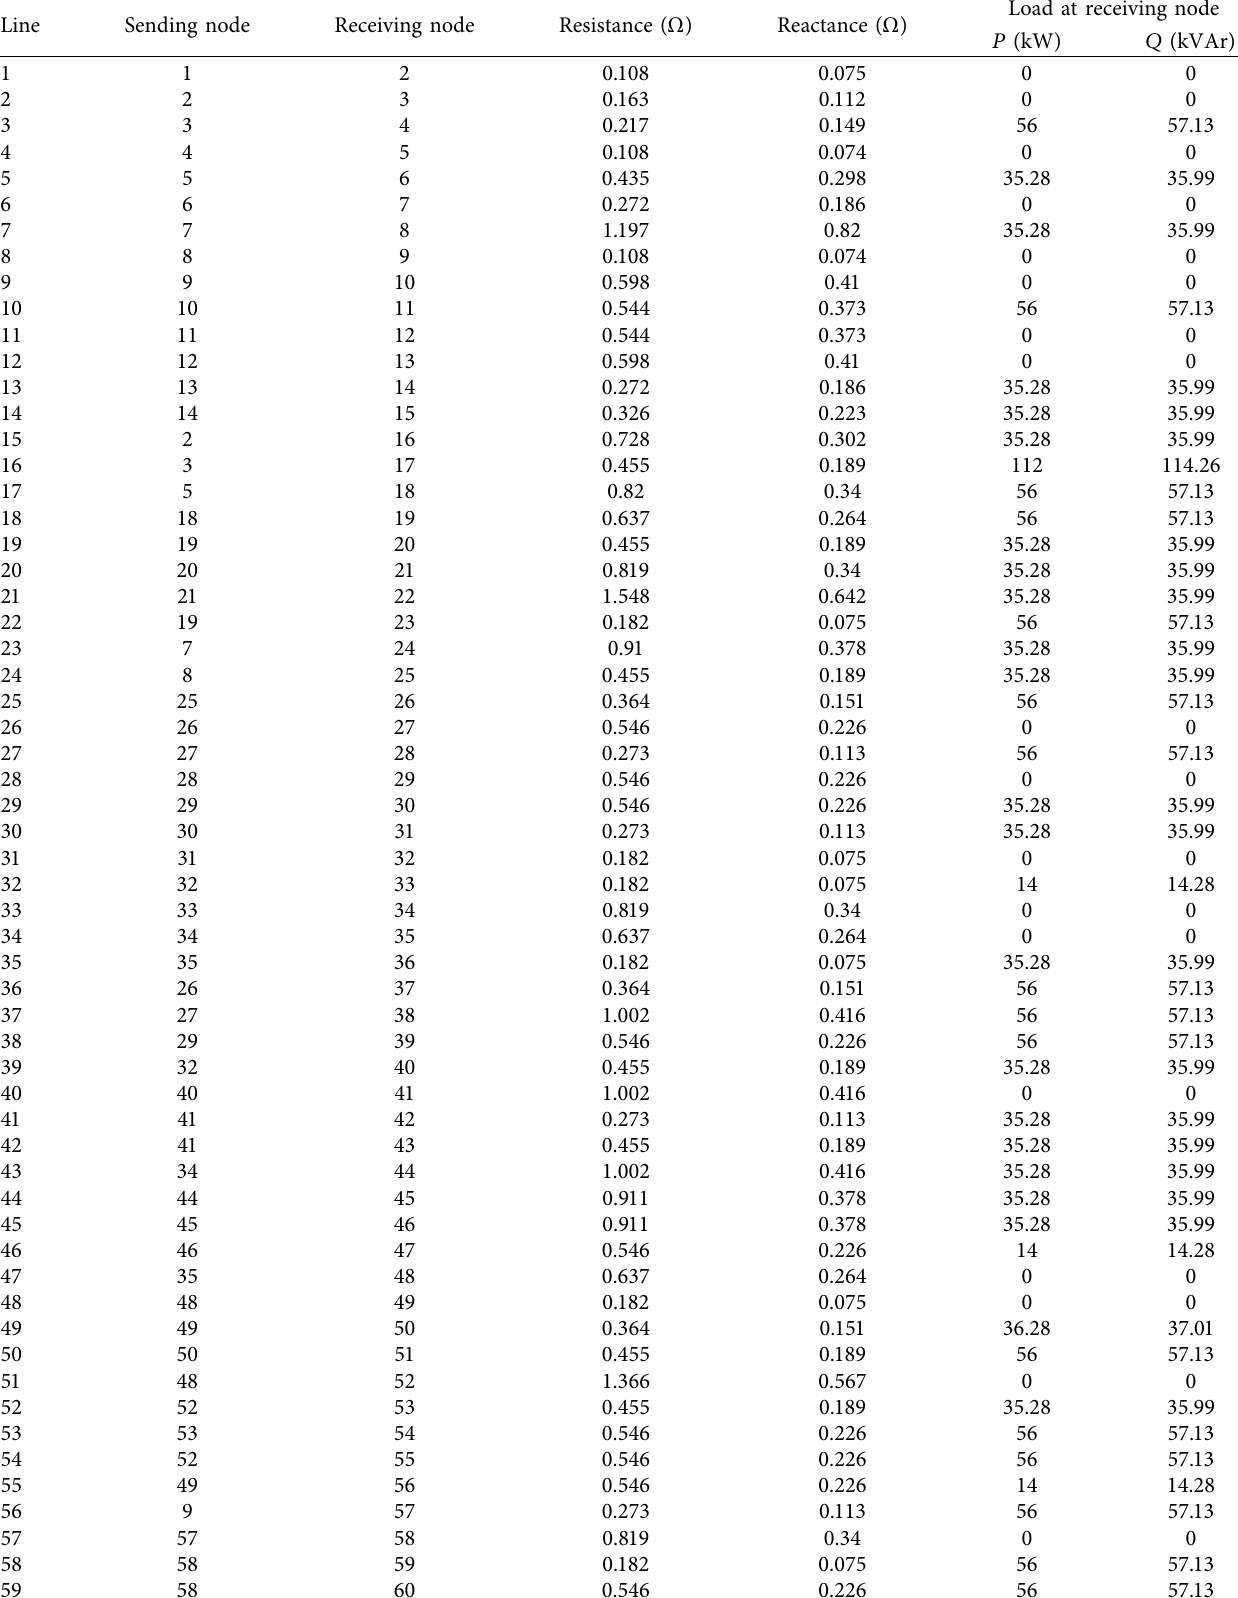
Table 7: Data of the third system with 85